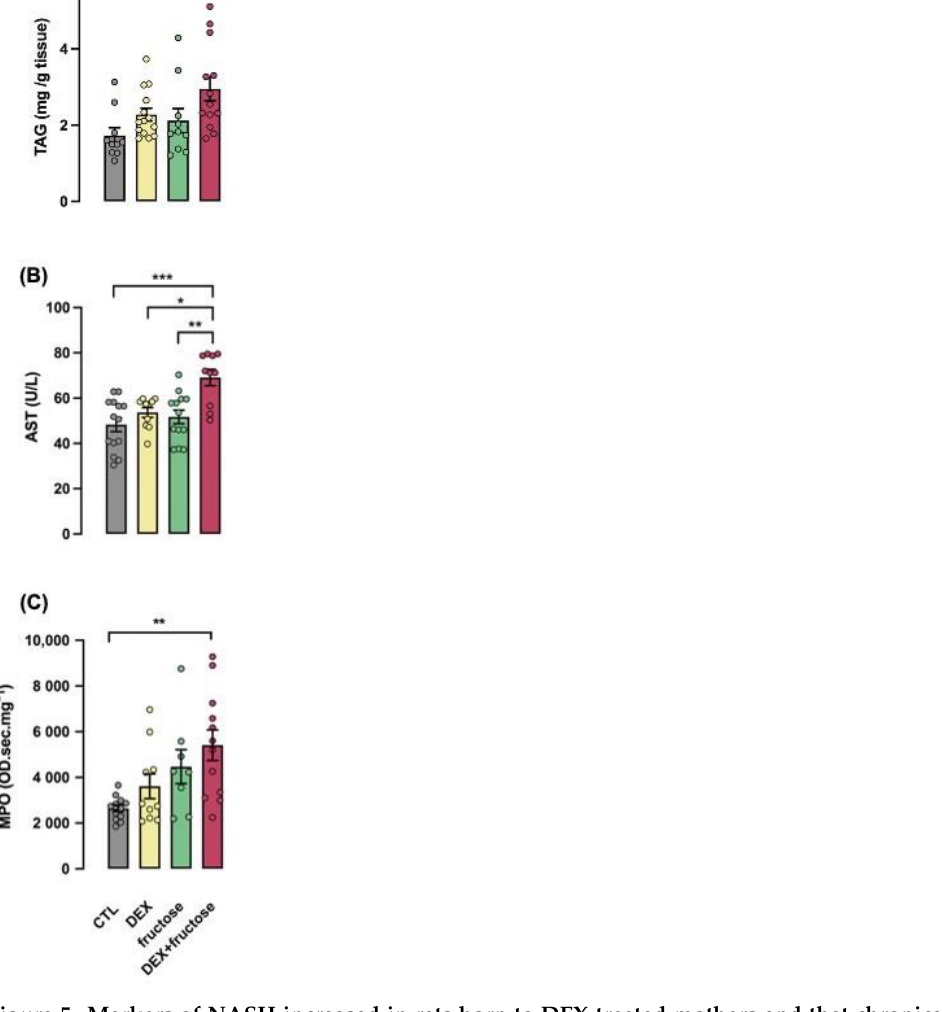
Figure 5. Markers of NASH increased in rats born to DEX-treated mothers and that chronically consumed fructose in adult life. Blood and liver samples of adult rats supplemented (fructose and DEX+fructose groups) or not (CTL and DEX groups) with fructose for 8 weeks were collected for analysis of hepatic content of triglycerides (TAGs) ( A ), circulating aspartate aminotransferase (AST) ( B ) and hepatic levels of myeloperoxidase (MPO) ( C ). Data are presented as the mean ± SEM; * p < 0.05; ** p < 0.01; *** p < 0.001 vs. the group indicated by the bracket. n = 10 to 13 for TAGs ( A ), n = 10 to 14 for AST ( B ) and n = 8 to 12 for MPO.